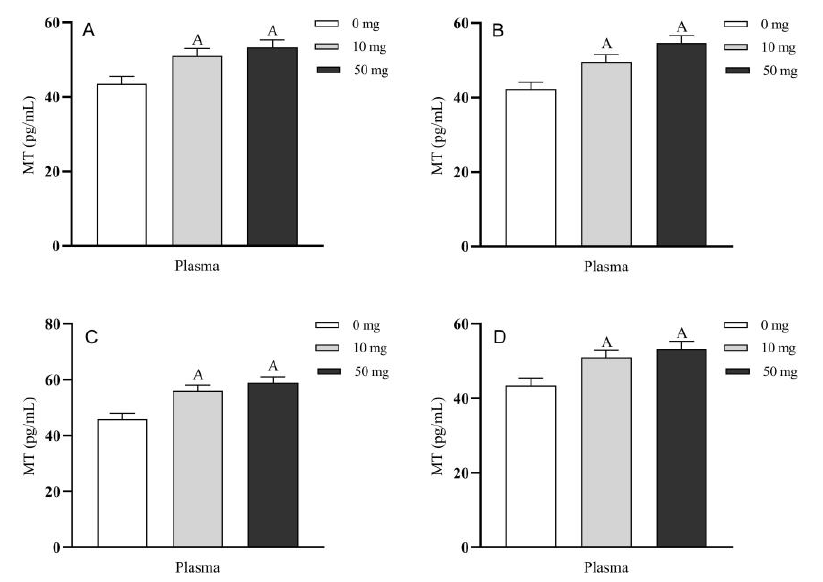
Figure 8. Blood MT concentrations in different blood vessels after 5-HTP duodenal perfusion. ( A )